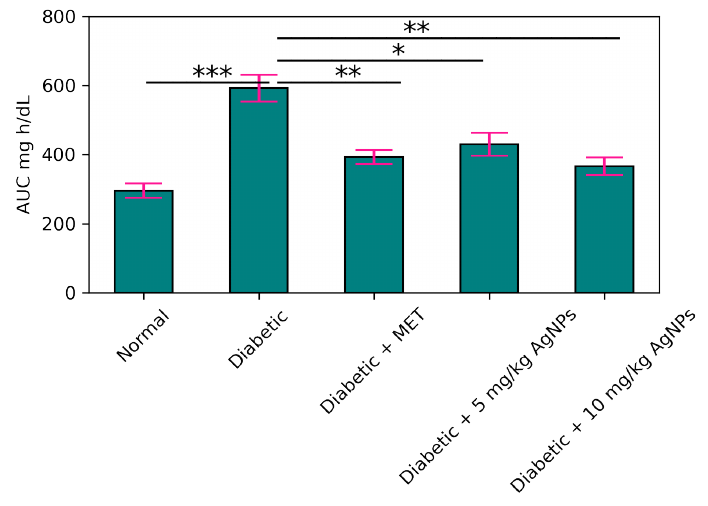
Figure 14. Area under the Curves (AUC) for IPGTT. The statistical significance of differences among different groups was analyzed using Two Way ANOVA Bonferroni test as implemented in Graph pad prism 5.0 software (* p < 0.05, ** p < 0.01, *** p <